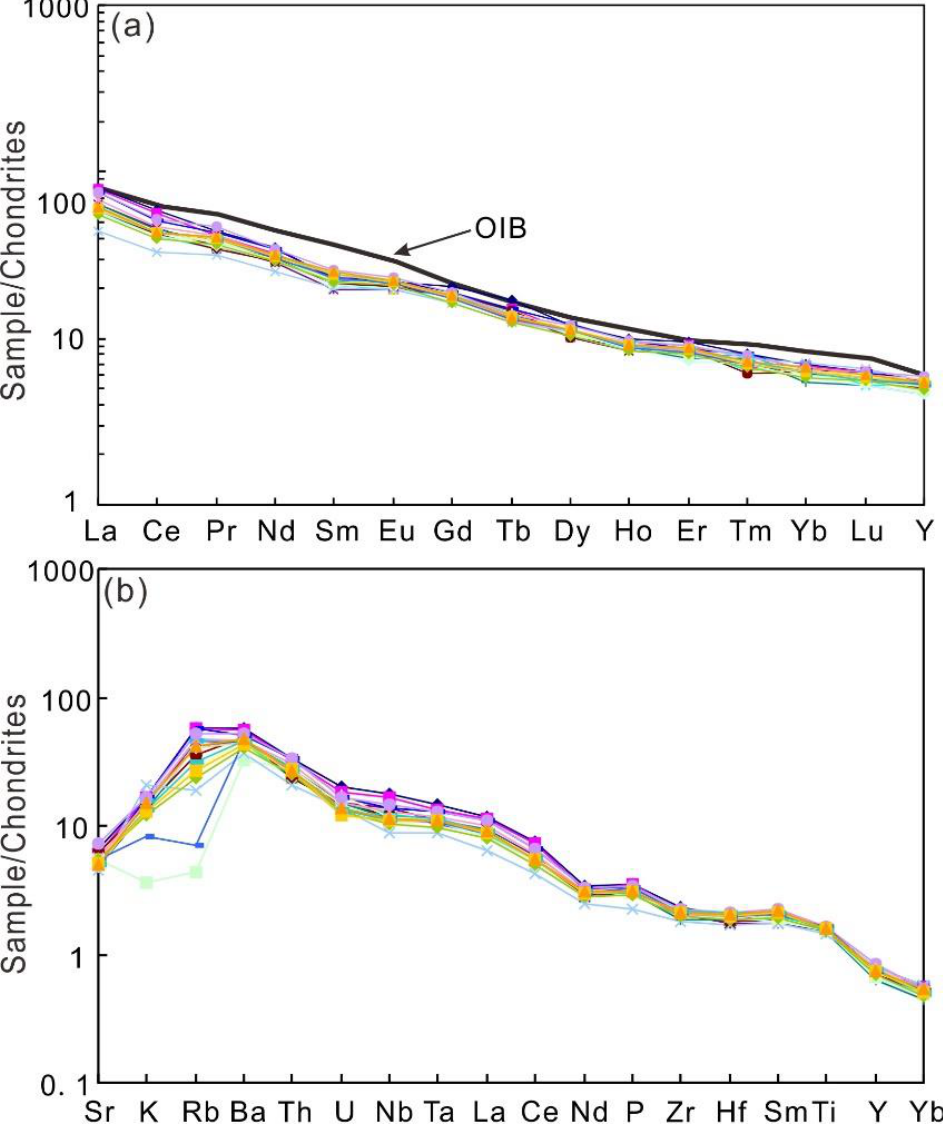
Figure 6. ( a ) Chondrite-normalized REEs of volcanic rocks from the Jiangling Basin (after [64]). ( b ) Spider diagram patterns of volcanic rocks from the Jiangling Basin (after [64]). OIB-Oceanic Island Basalt.